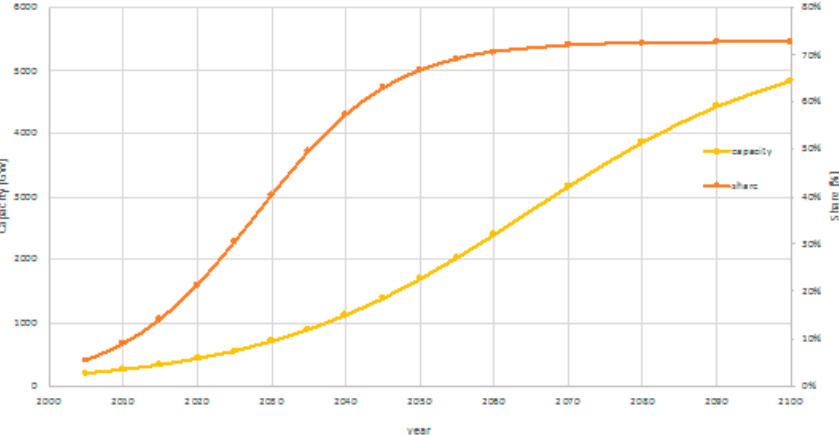
Figure 3. Europe PV technology capacity development based on the reference scenario of REMIND until the year 2100 (own work).